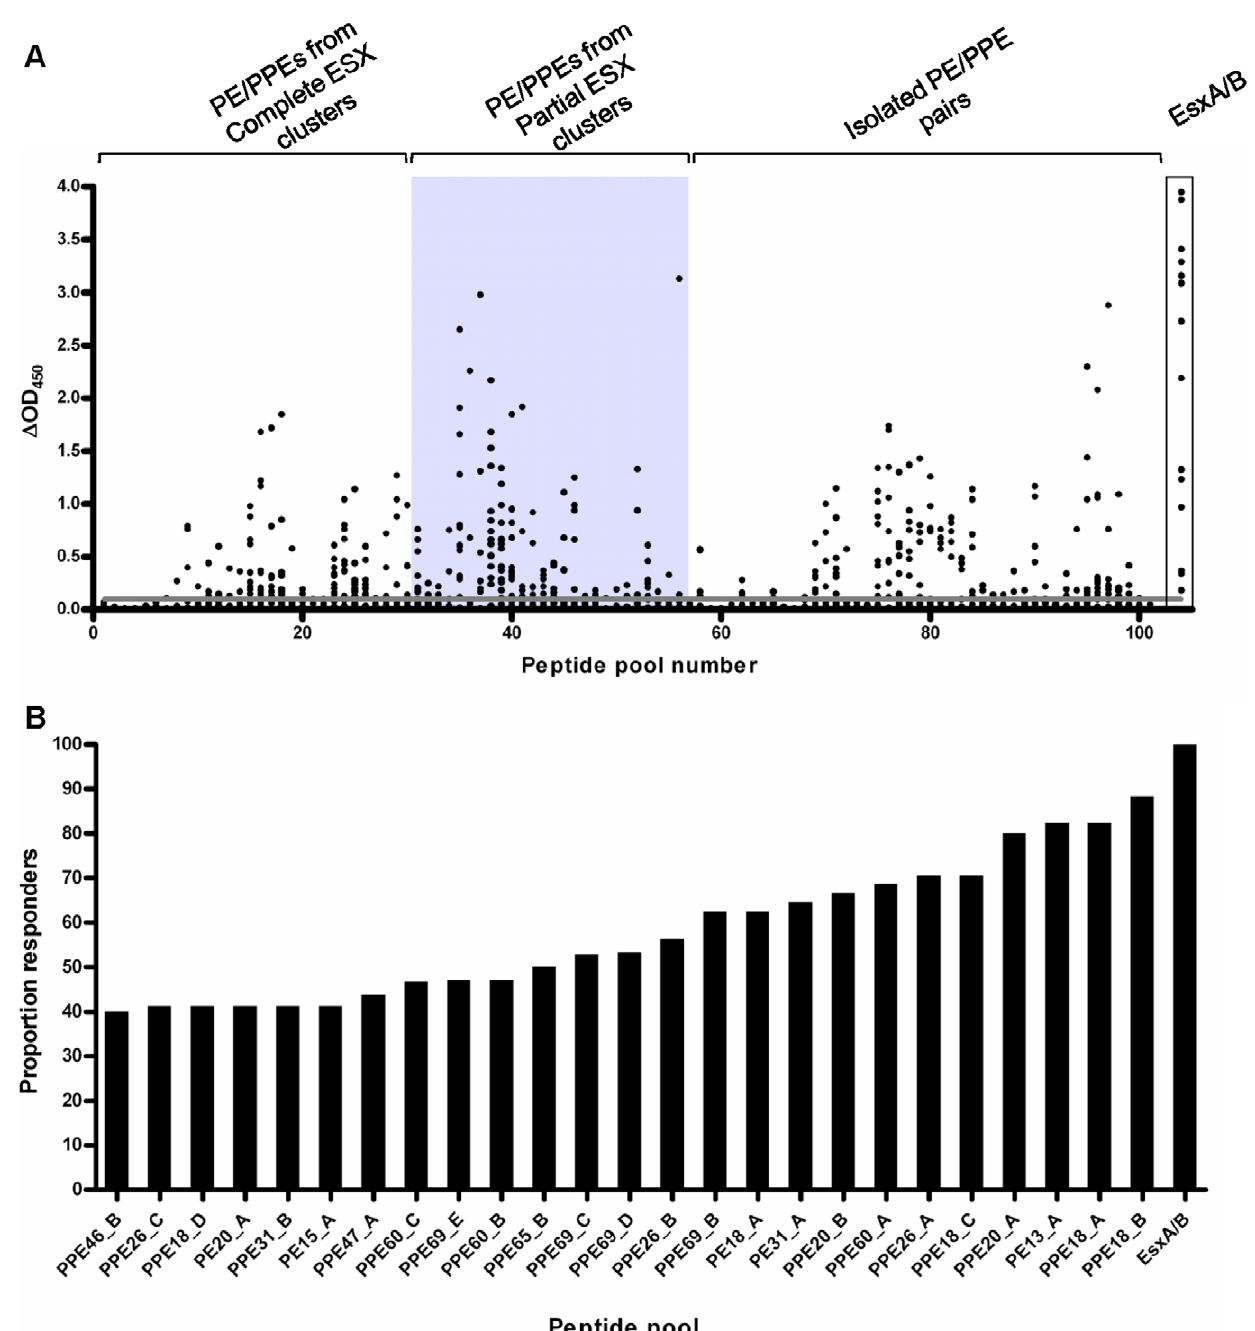
Figure 1. IFN- c responses to PE/PPE peptide pools in experimentally infected cattle. Whole blood from cattle experimentally infected with 3 6 10 3 CFU M. bovis AF2122/97 was stimulated with pools of peptides representing 36 PE/PPE proteins at 12–14 weeks post-infection. IFN- c production was assessed by the ELISA-based Bovigam assay. (A) IFN- c responses to 101 PE/PPE peptide pools in experimentally infected cattle (n=17) expressed as OD 450 – Nil antigen well reading ( D OD 450 ). Grey box highlights responses to PE/PPE peptides derived from PE/PPE proteins encoded by partial esx regions. Peptides derived from PE/PPE proteins from complete ESX regions and those encoded as isolates PE/PPE pairs are also indicated. Responses to an EsxA/B peptide cocktail are also shown for comparison. (B) Twenty-five PE/PPE pools that elicited positive responses in $ 40% cattle tested, ranked according to proportion responders. doi:10.1371/journal.pone.0040890.g001 individuals (58.8%) recognized $ 10 pools each (mean number of humans exposed to M. bovis and M. tuberculosis , respectively pools recognized, 12.0; SD, 8.3; range, 22). (Figure 2, Table 2). Ten pools were recognized in $ 50% of individuals for both species. There was a statistically significant We then compared immune recognition in the two species. This correlation between responses in humans and cattle, both as revealed a similar immune recognition hierarchy in cattle and